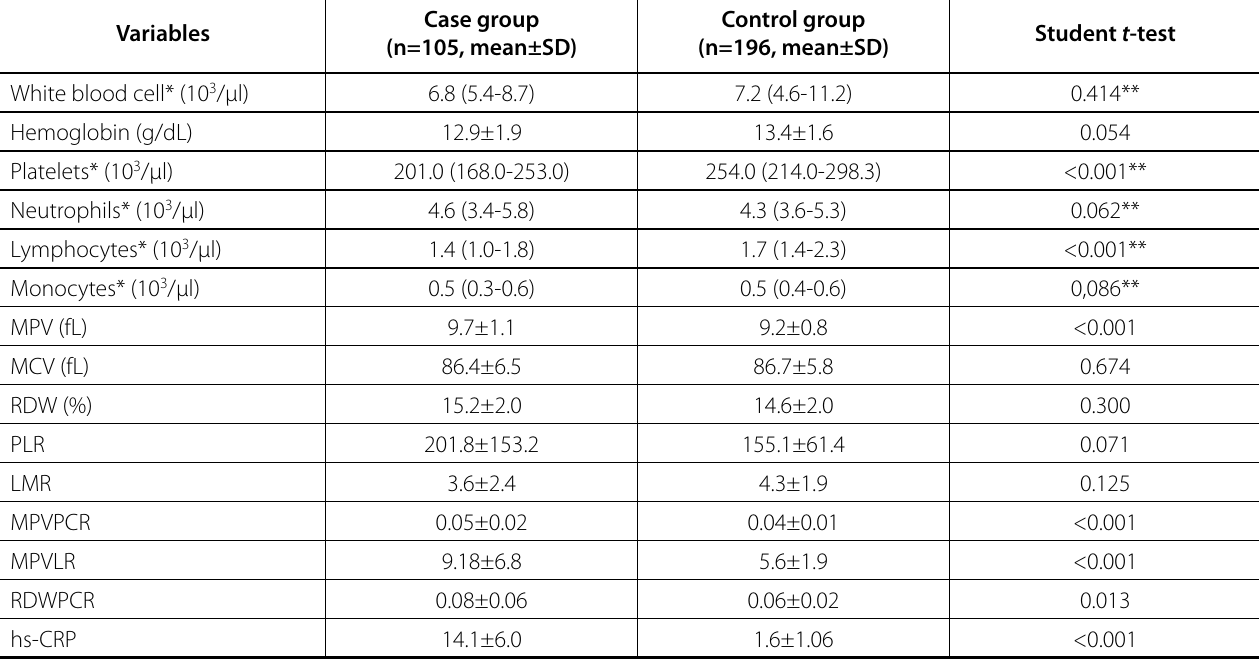
Table 2 . Mean and median values of blood parameters of the case group versus control